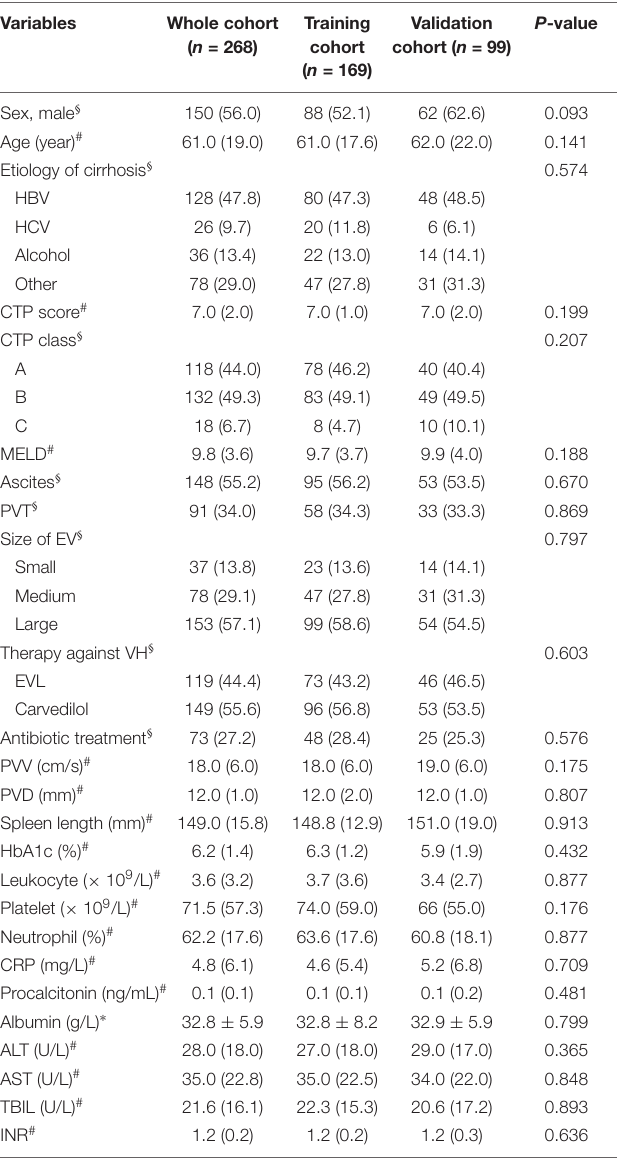
TABLE 1 | Demographic and clinical characteristics of the training and validation cohorts.